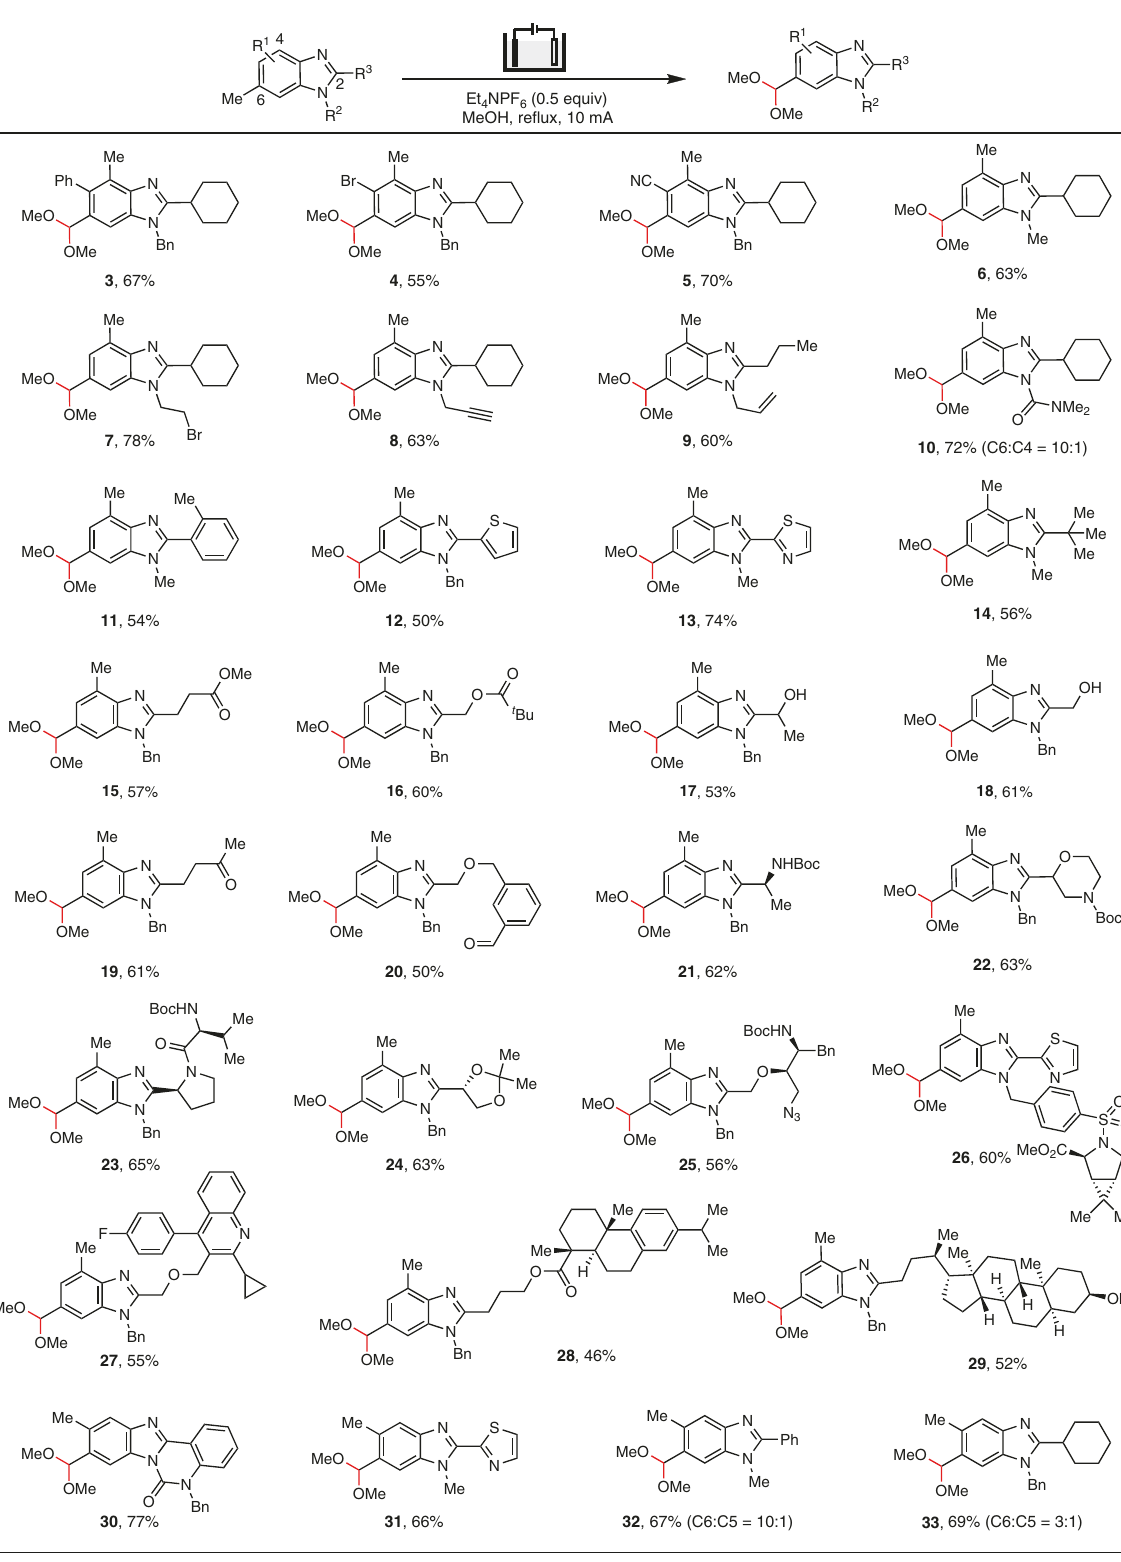
Fig. 2 Scope of site-selective electrooxidation of benzimidazoles. Reaction conditions: heterocycle (0.2 mmol), MeOH (0.022 M), re fl ux, 2.2 – 4.5 h. All yields are isolated yields. Regioisomers were not observed unless otherwise